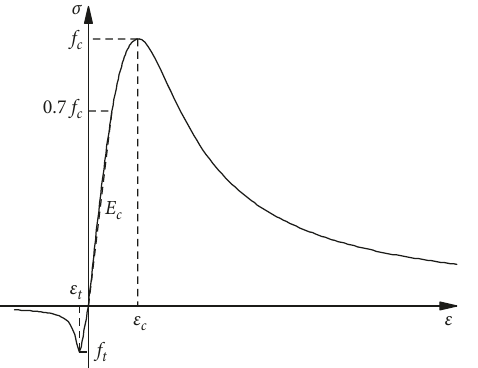
Figure 18: Uniaxial constitutive stress vs. strain relations for the CDP